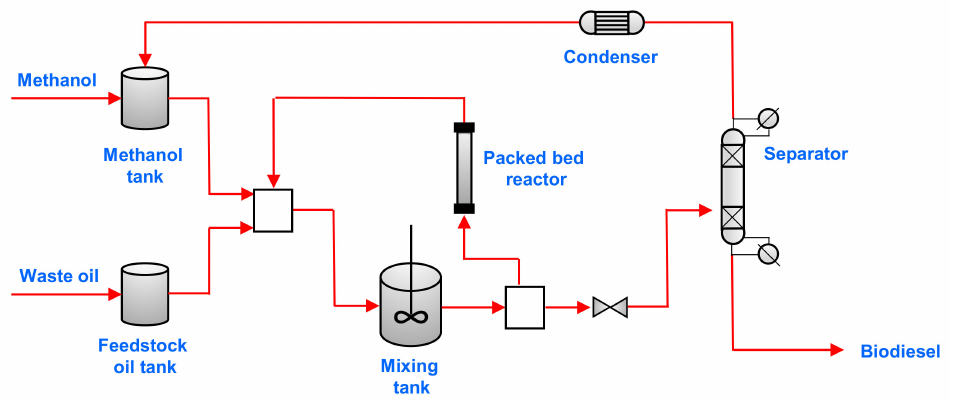
Figure 4. Packed bed reactor (PBR) for continuous process for biodiesel